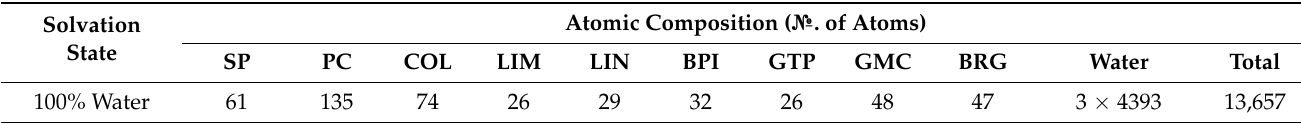
Table 5. Atomic composition of the constructed BEO-NPs-SP formulation simulated